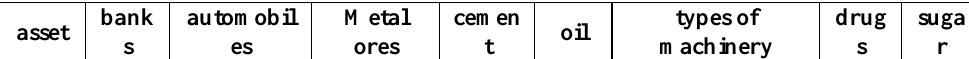
Table 8. the optimal portfolio of the Markowitz